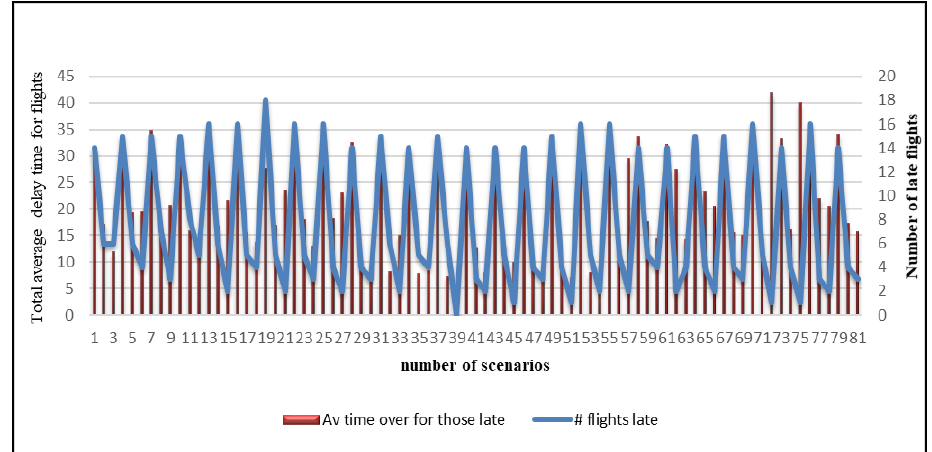
Figure 8. Influence of the static method on boarding procedures.